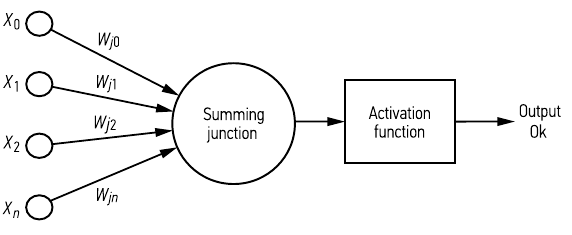
Arrangement of neurons into layers and the pattern of connection within and in-between layers are generally called the architecture of the net. The process of modify- ing weights according to connections between network layers, with the objective of achieving expected output is called training a network. Internal process that takes place when a network is trained is called learning. Gen- erally there are three types of training: supervised, unsu- pervised and reinforcement. Weight is information used Fig. 2. Nonlinear model of a neuron by neural network to solve a problem. Neural networks consist of a large number of processing elements called